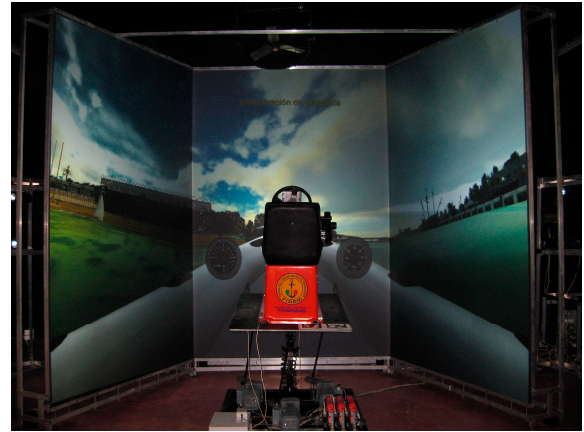
Figure 5. One possible realization of setup #3. Multimodal Technol. Interact. 2017 , 1 , 10